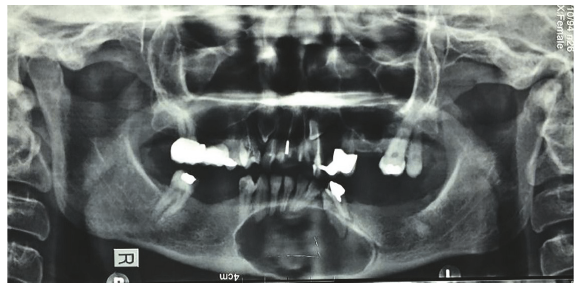
Figure 1: Panoramic radiograph shows a single large radiolucent lesion with well-defined